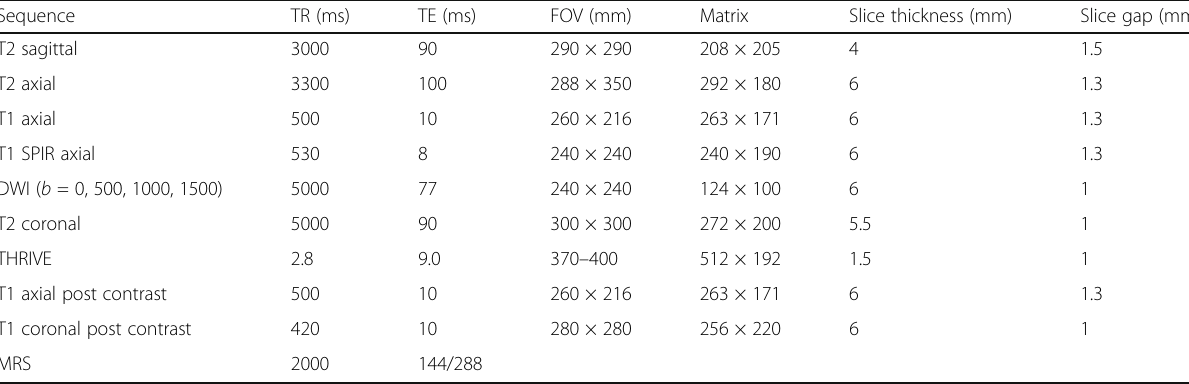
Table 2 MR imaging parameters